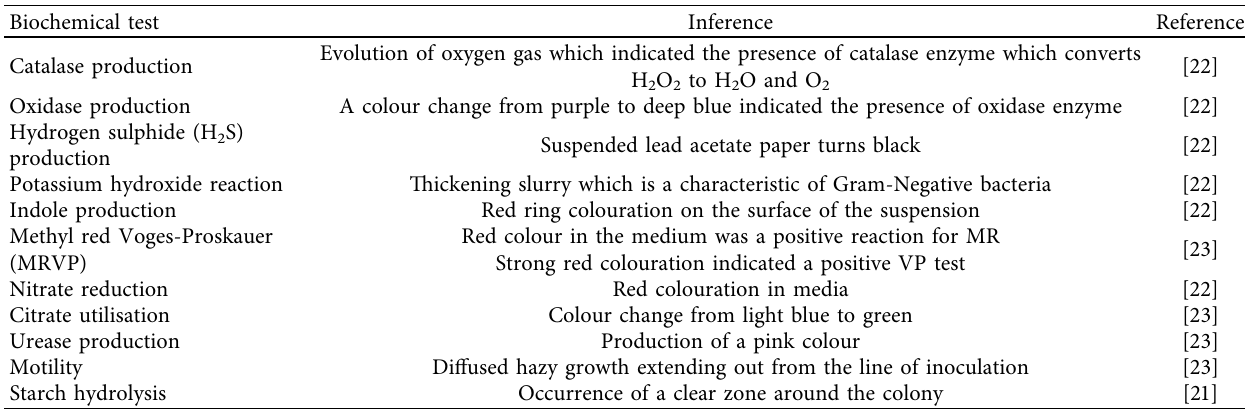
Table 1: Biochemical tests